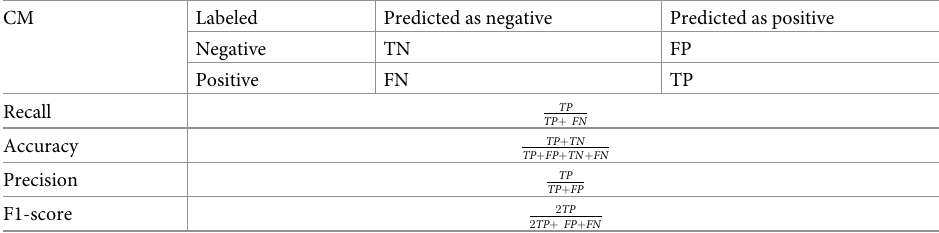
Table 1. Calculation formulae for the evaluation indicators of the model.